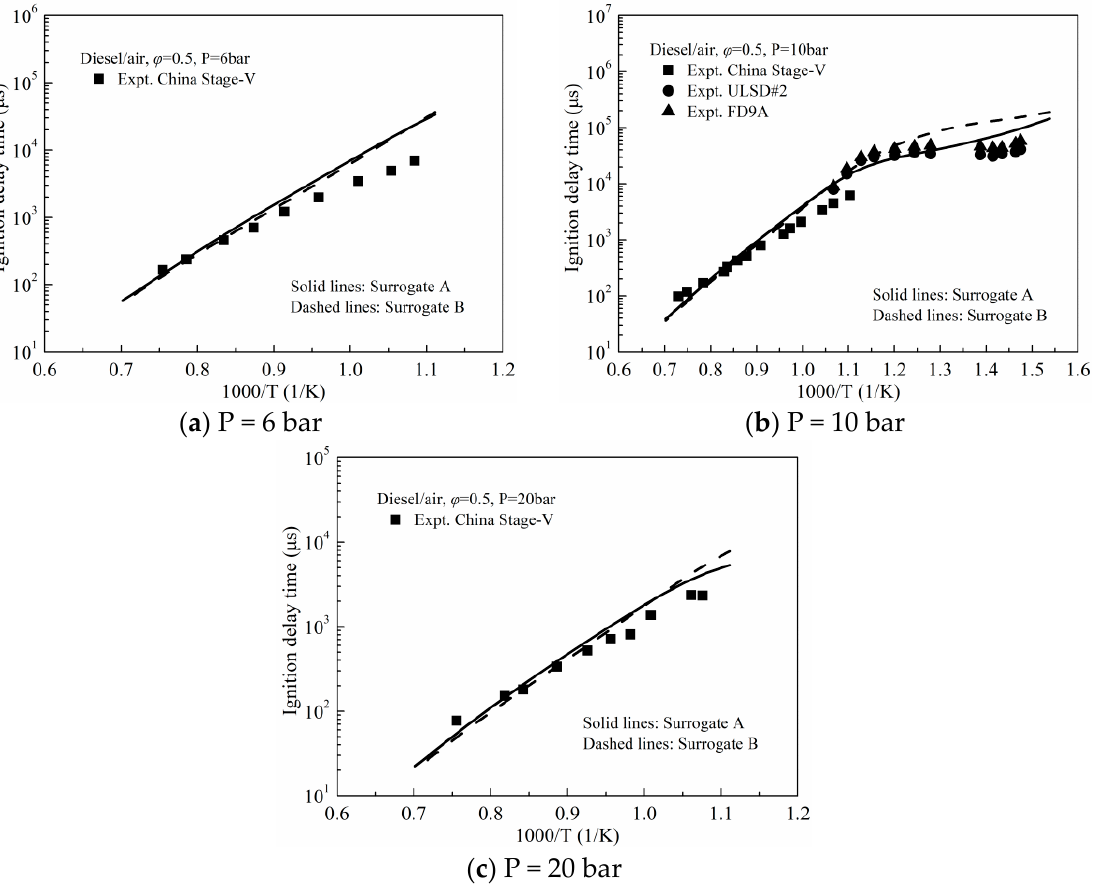
Figure 5. Ignition delay comparisons between simulation and experiment [31–34] for diesel fuel at φ = 0.5. Symbols: experiment; lines: simulation.